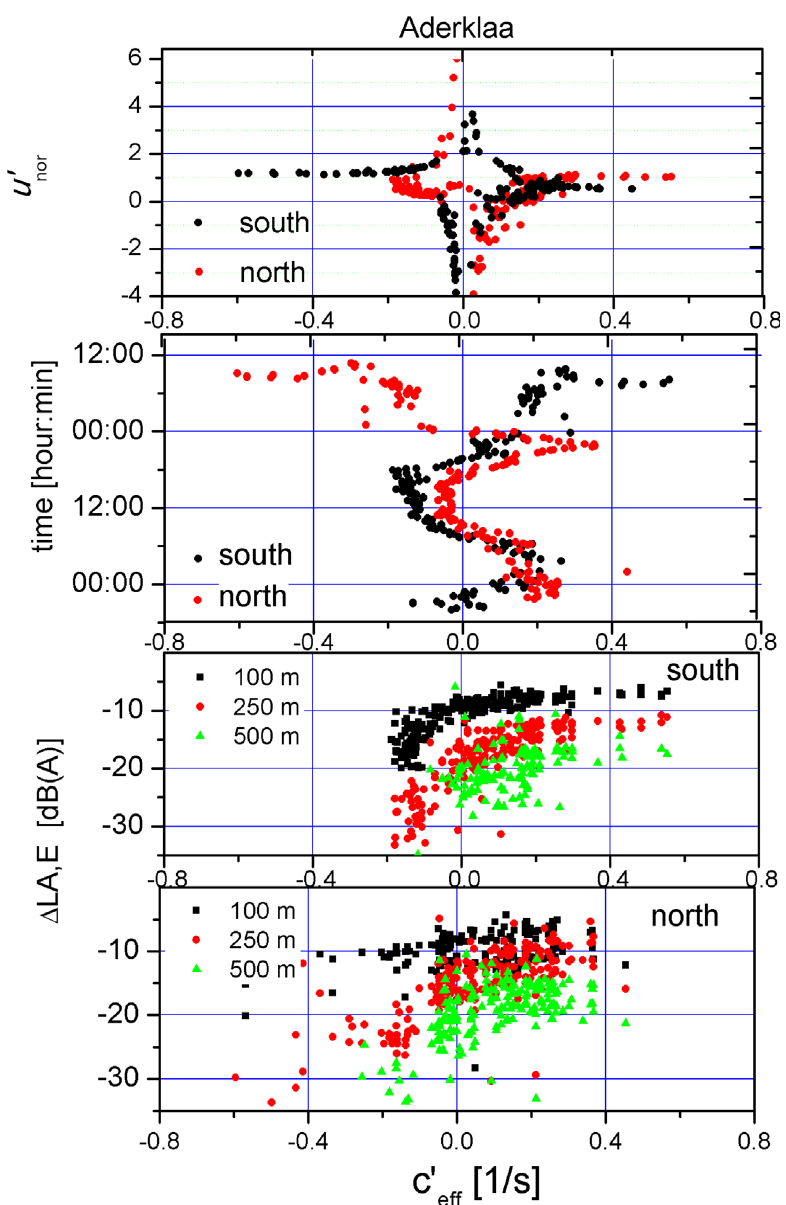
Figure 9. Aderklaa: The uppermost diagram shows the normalized wind speed gradient ( u 0 nor ¼ u 0 cos a c 0 eff ). The middle fi gure shows the temporal distribution of c 0 eff . The lowest graph shows the sound exposure level difference D L A , E as a function of c 0 eff for different distances from the sound source. A distinction is made between the southern and northern measuring